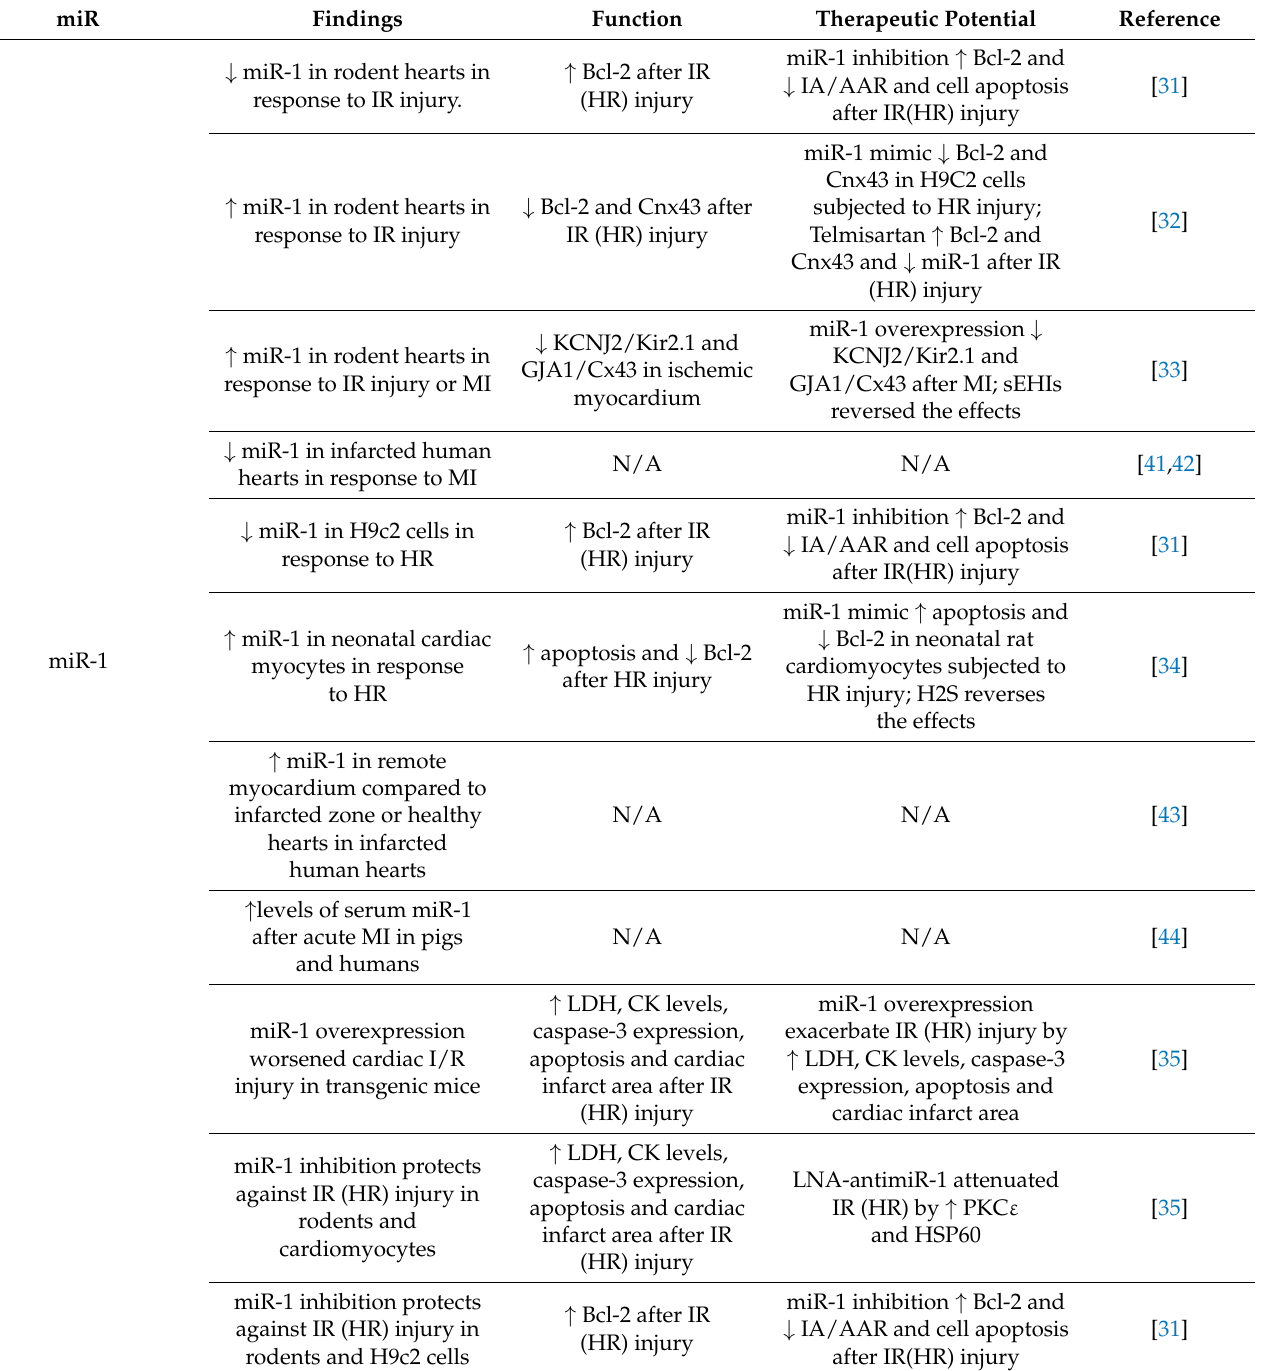
Table 1. Summary of most relevant cardiac injury studies related to miR-1 and miR-21 cardiac